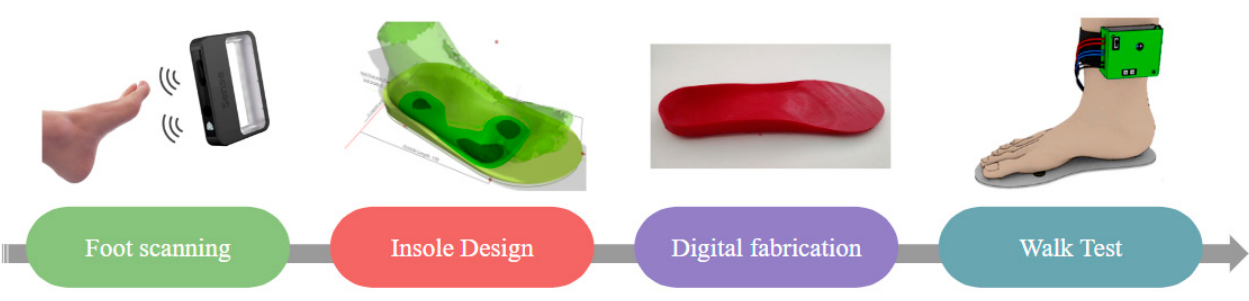
Figure 1. Digital manufacturing workflow for 3D-printed